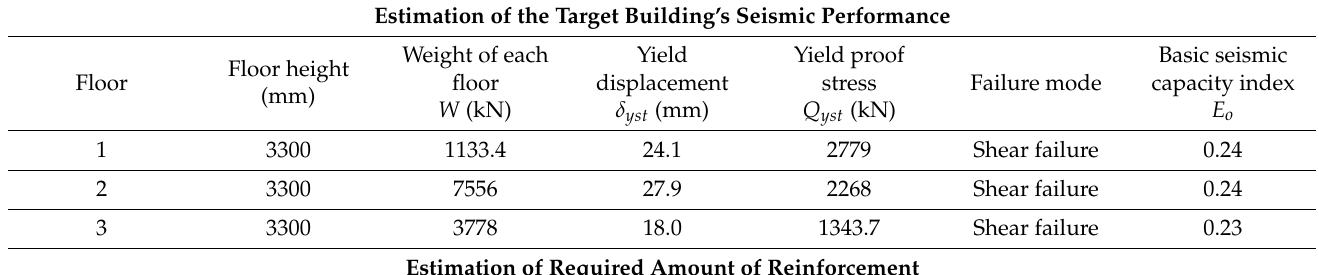
Table 14. Estimated amount of seismic reinforcement for the NBSD-based seismic control system. Estimation of the Target Building’s Seismic